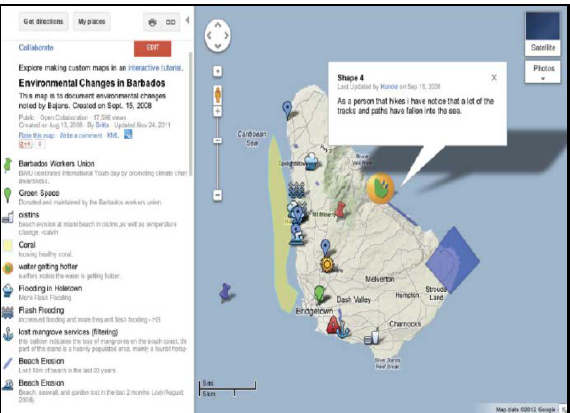
Figure 4: Google My Map interface and result in